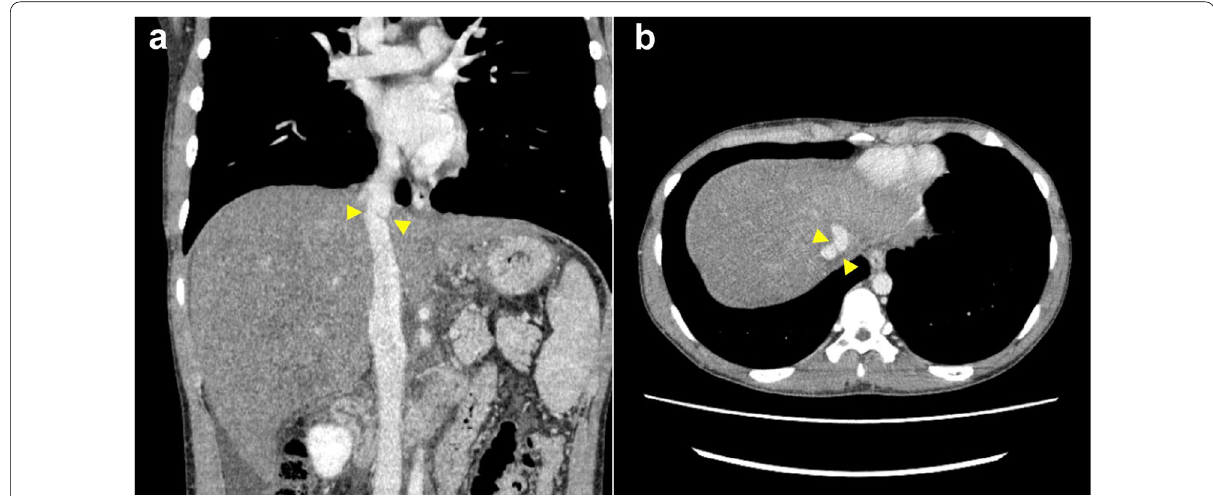
Fig. 1 Preoperative abdominal computed tomography (CT) showing the membranous-like stenosis (yellow arrowhead) and non-perfusion of the main hepatic veins ( a coronal section, b axial section)